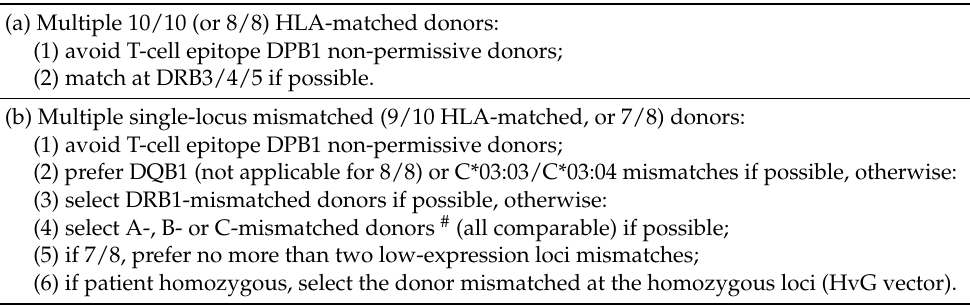
Table 2. Suggestions for the selection of unrelated donors according to the HLA matching